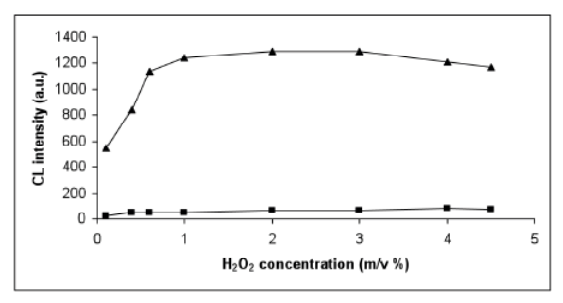
Figure 5. The effect of H the absence ( ■ ) and in the presence ( ▲ ) of 40 mg L -1 PVK. Reagent